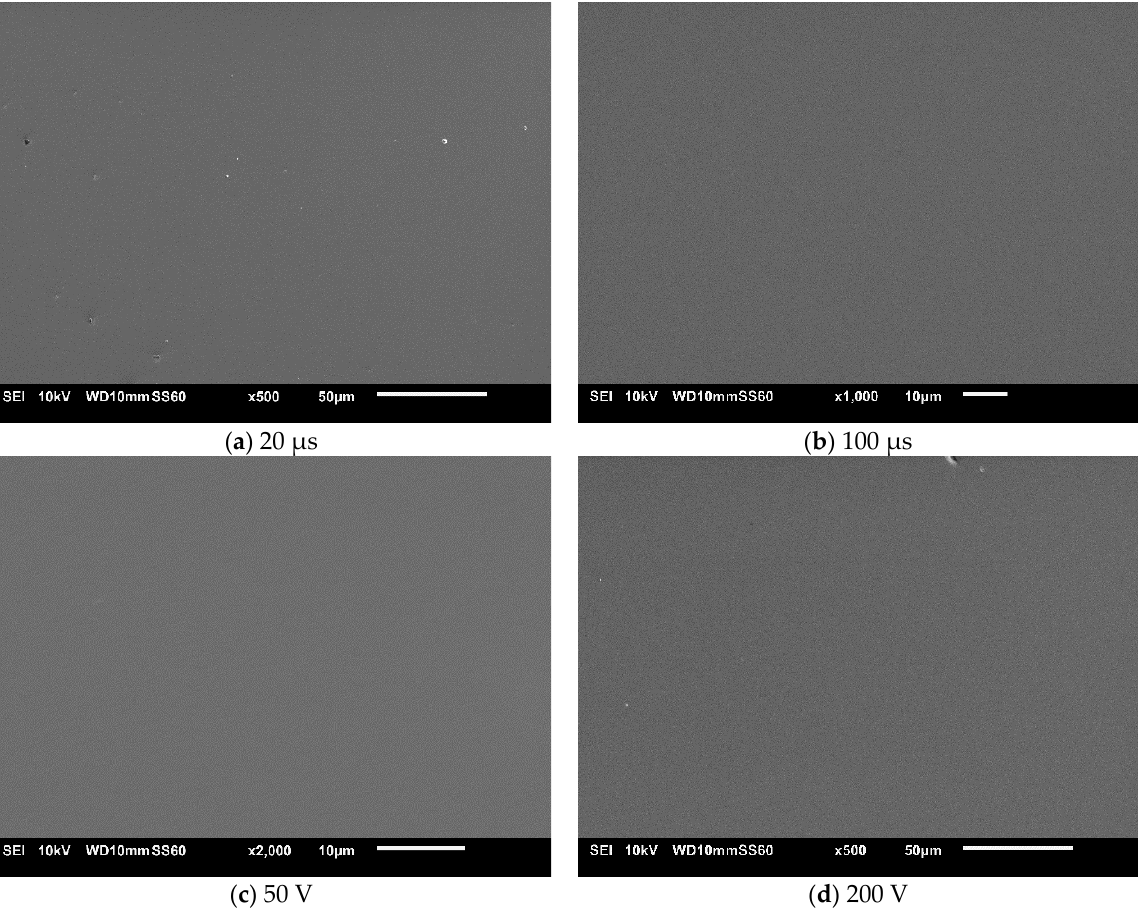
Figure 2. SEM images of selected coatings deposited with a (a) 20 µs pulse duration, (b) 100 µs pulse duration, (c) 50 V bias voltage, and (d) 200 V bias voltage.